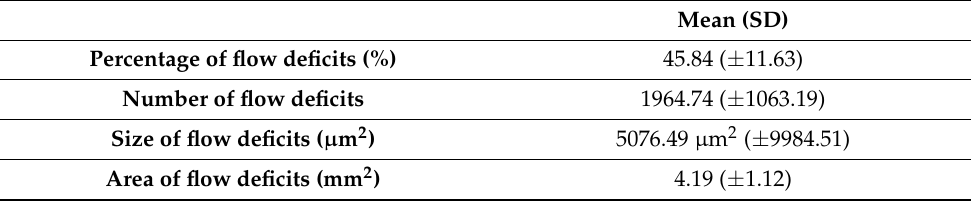
Figure 4. Choriocapillaris abnormalities of an eye with intermediate AMD. Enhanced depth imaging spectral domain optical coherence tomography (EDI-SD-OCT) visualized numerous drusen ( A ) which appeared hypofluorescent on indocyanine green angiography (ICGA) ( B ). On the manual choriocapillaris segmentation of the 3 × 3 mm 2 OCTA ( C ), multiple flow deficits were noticed in the CC flow image, corresponding in part to signal attenuation generated by drusen. Panel ( D ) corresponds to the structural en face CC slab, while panel ( E ) represents the corresponding B-scan with flow overlay.